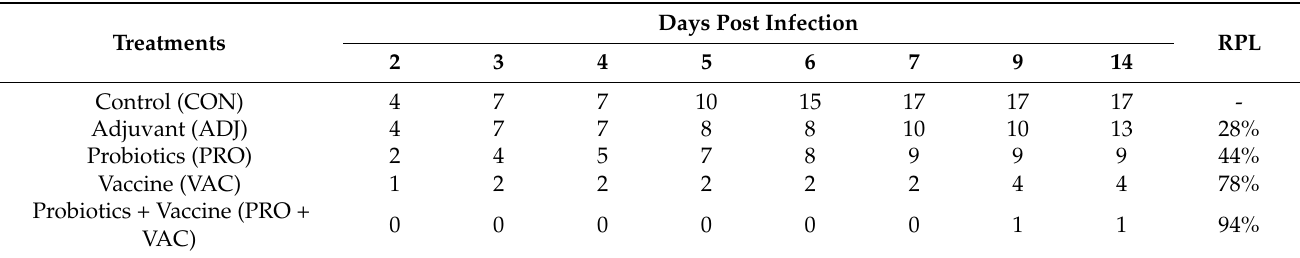
94% Table 2. Accumulated fish mortality during S. agalactiae infection challenge of 5 aquarium with n = 30/treatment (number of fish per challenge group). 6 fish/tank/challenge group and relative protection level (RPL%) of homologous vaccine. Significant differences with control, by the Mantel–Cox log-rank test: (probability, p < 0.05). Days Post Infection